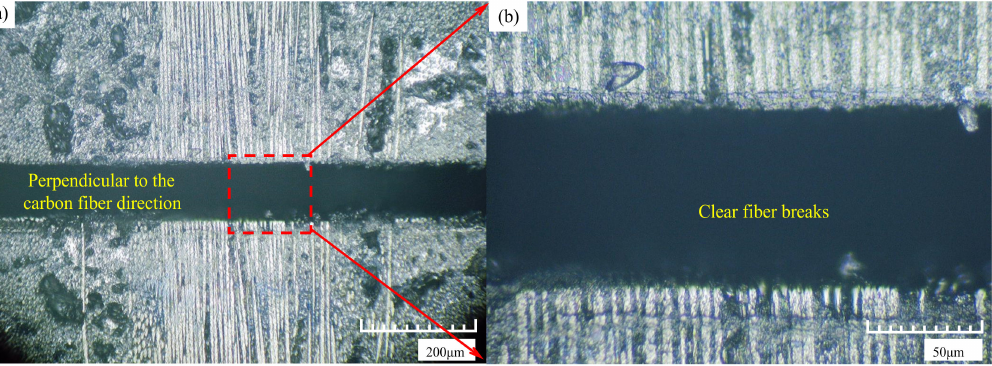
Figure 16. Vertical fiber direction processing end surface (( a ). the groove morphology at the fiber fracture; ( b ). partial enlargement of the picture).